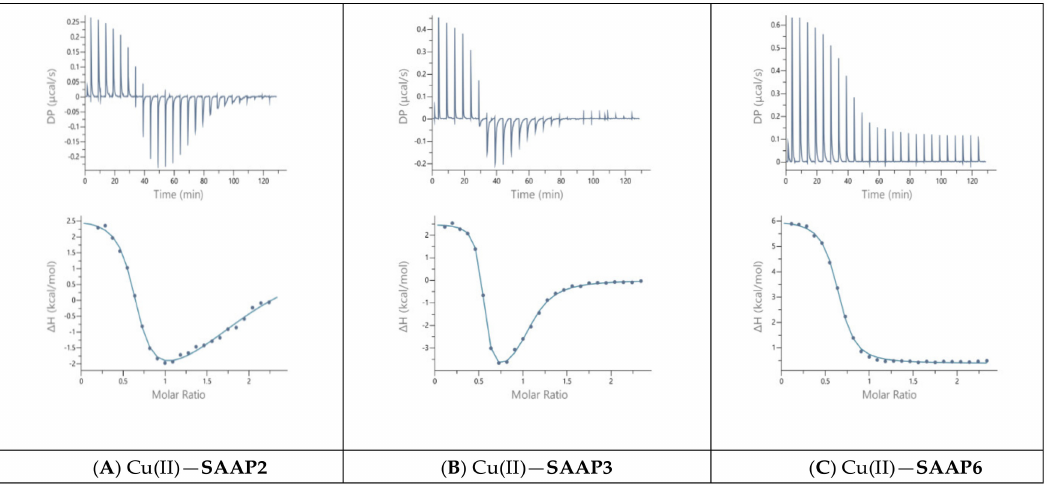
Figure 6. Representative ITC data for Cu(II) (1.8 mM) titrated into ( A ) SAAP2, ( B ) SAAP3, and ( C ) SAAP6 peptides (150 µ M) at pH